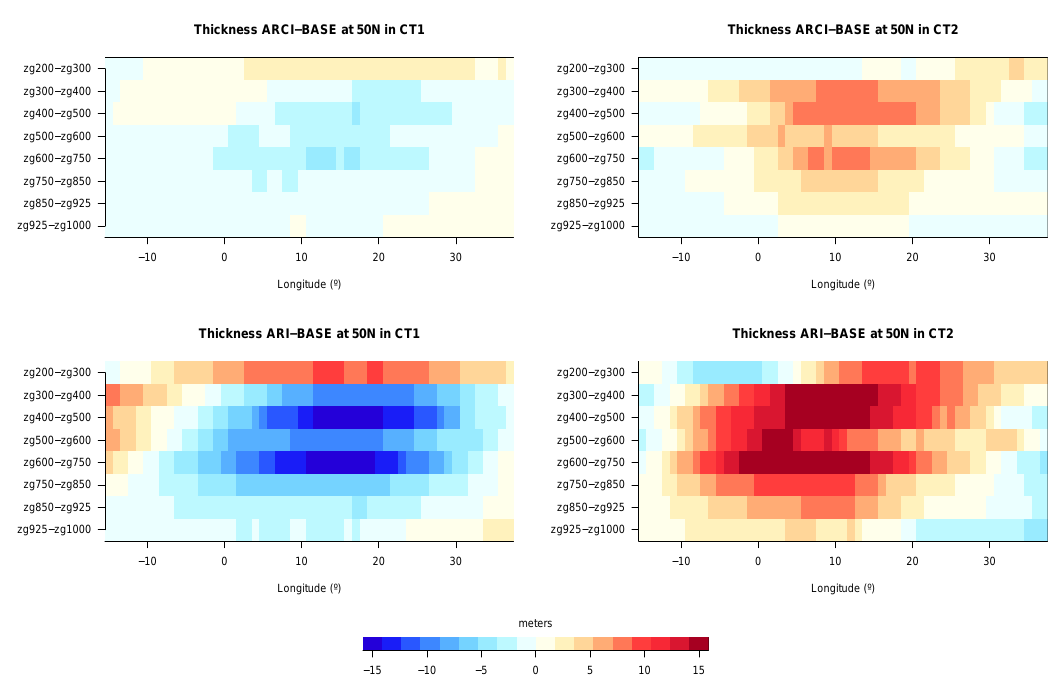
Figure 4. Differences in layer thickness ARCI − BASE ( top ) and ARI − BASE ( bottom ) at 50 ◦ N in CT1 and